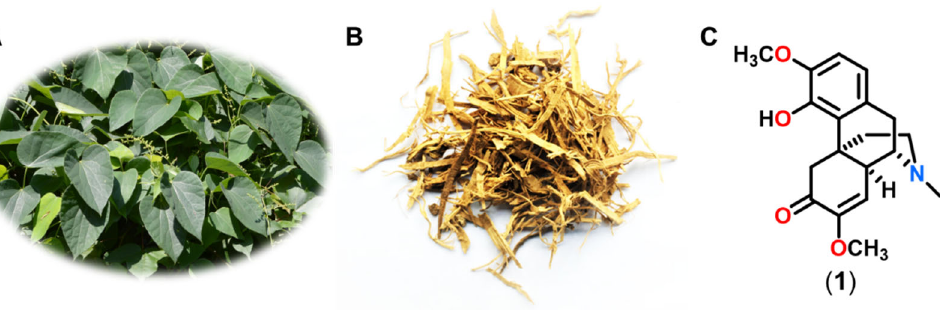
Figure 1. Traditional use of S . acutum and clinical application of its main active component, sinomenine. ( A ) Plant S . acutum ; ( B ) dry rattan stem of S . acutum , the picture is reproduced with permission; ( C ) structure of sinomenine .